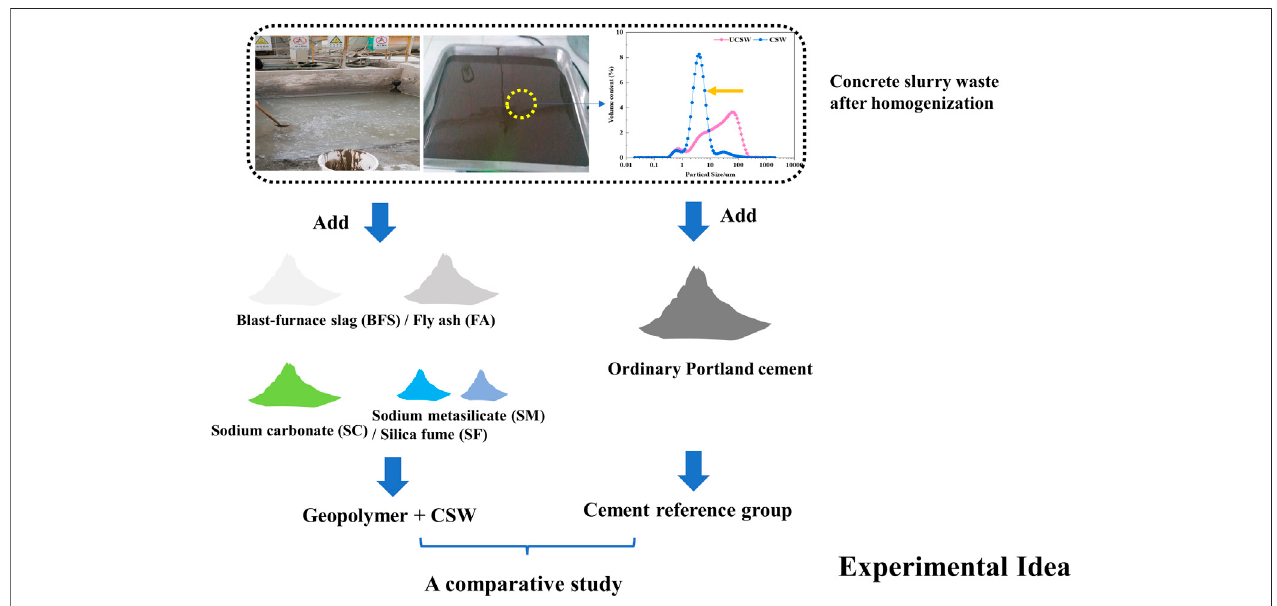
FIGURE 1 | Experimental idea of this